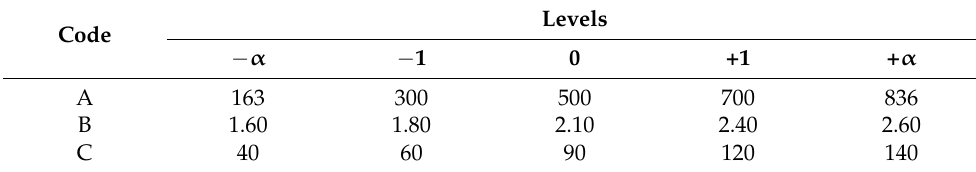
Table 2. Survey value levels of three extracted factors in the model.